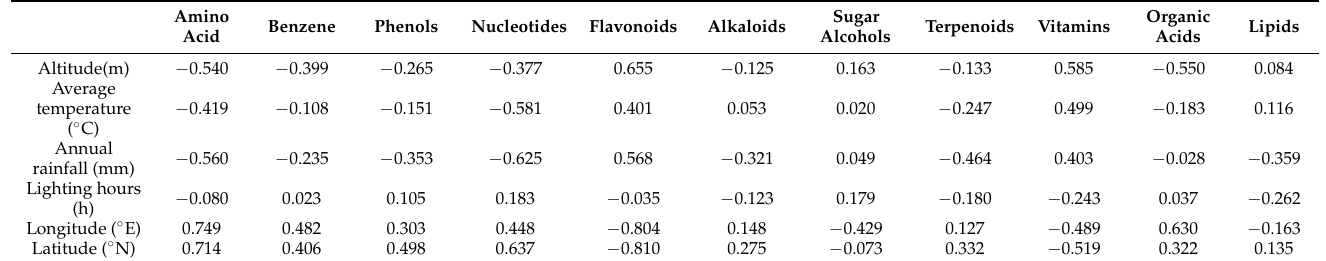
Table 2. Correlation analysis between climatic and major metabolite classes in C. speciosa .